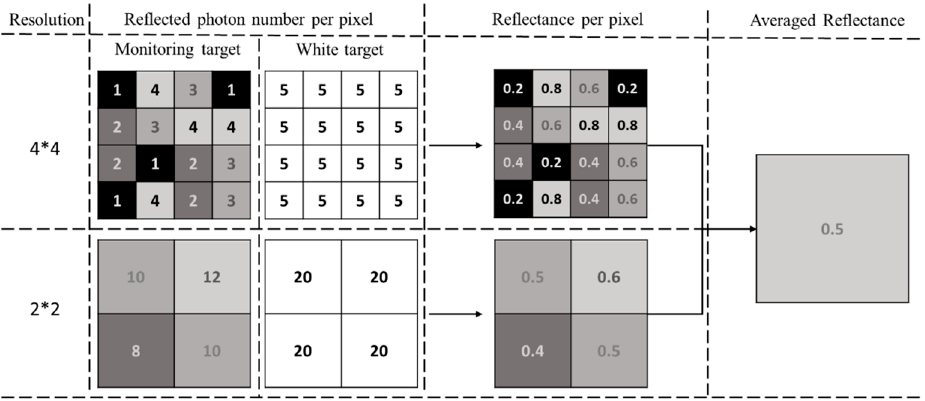
Figure 12. Reflectance generation process based on 2 × 2 and 4 × 4 pixels.